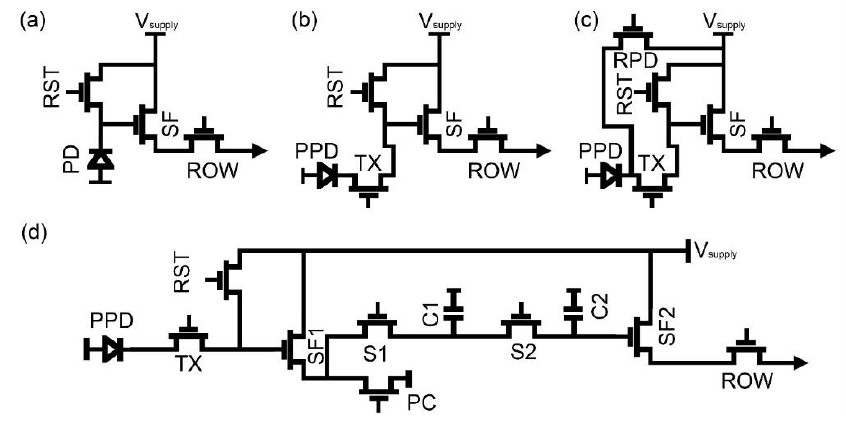
Figure 1. Pixel circuit schematic of ( a ) 3T, ( b ) 4T, ( c ) 5T, and ( d ) 8T GSI pixel.